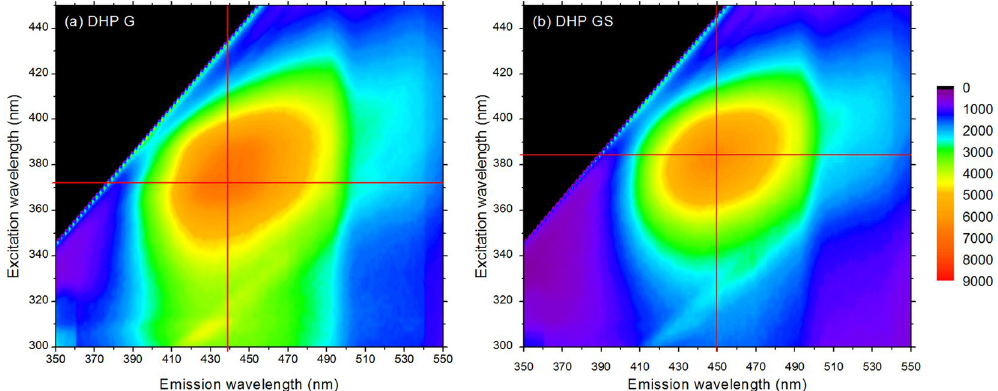
Figure 3. 3D fluorescence contour map of model lignin DHPs: ( a ) DHP G made of 100% coniferyl alcohol and ( b ) DHP GS made of 50% coniferyl alcohol + 50% sinapyl alcohol. The red cross indicates the maximum fluorescence intensity value.